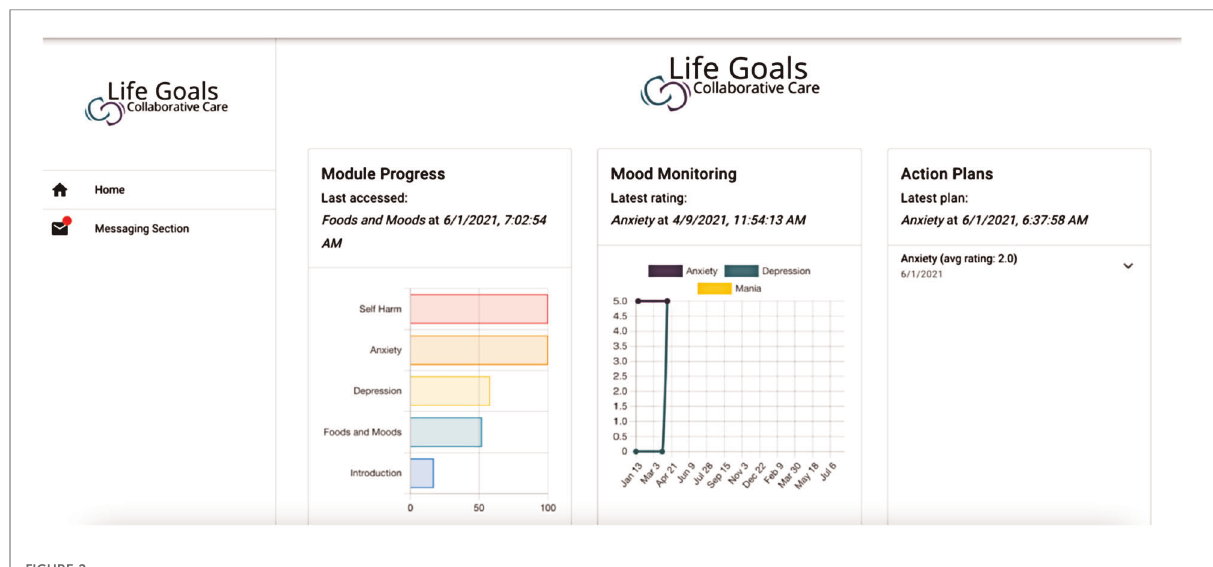
FIGURE 2 Life Goals provider dashboard home